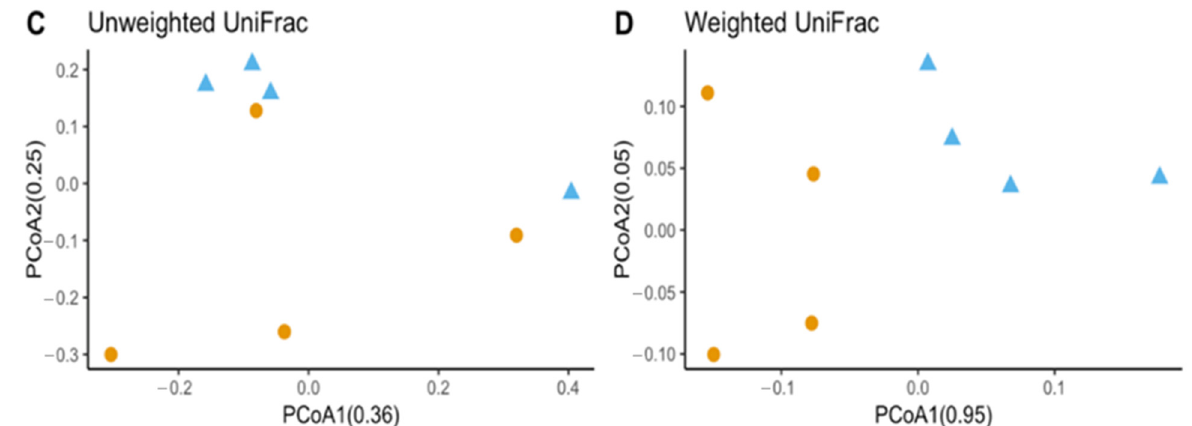
Figure 3. Beta diversity between laboratory-reared T. stercorea larva and adult gut microbiota composition. ( A ) Jaccard PCoA graph showing PCoA1 (0.31 variation) and PCoA2 (0.22 variation). ( B ) Bray–Curtis PCoA graph showing PCoA1 (0.95 variation) and PCoA2 (0.02 variation). ( C ) Unweighted UniFrac PCoA graph showing PCoA1 (0.36 variation) and PCoA2 (0.25 variation). ( D ) Weighted UniFrac PCoA graph showing PCoA1 (0.95 variation) and PCoA2 (0.05 variation). Blue triangles ( ▲ ) denote larvae and orange circles ( ● ) denote adults.